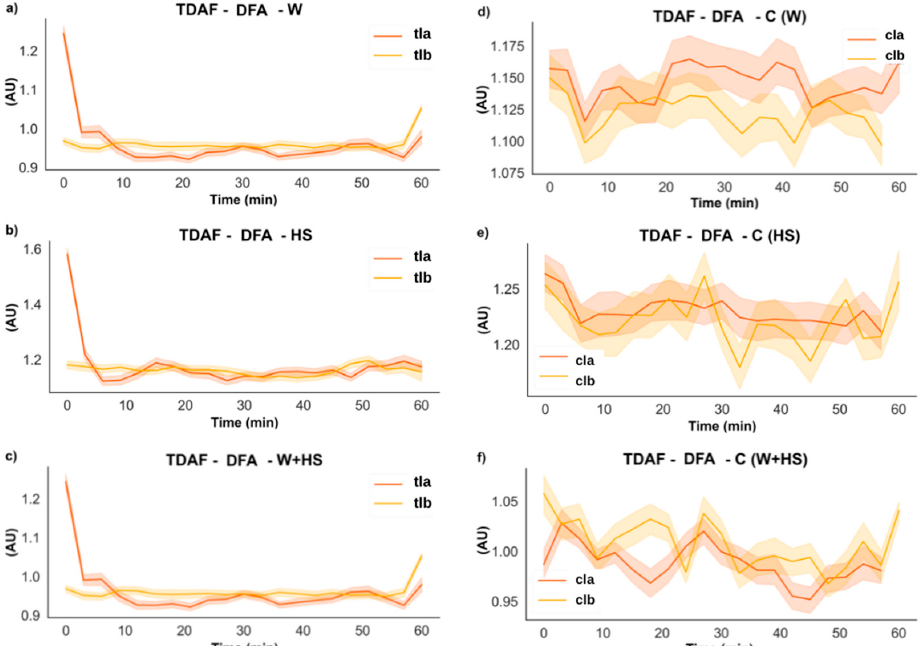
Figure 5. TDAF plots for DFA analysis. Results for ( a ) the local wound (W), ( b ) heat shock (HS), and ( c ) wound + heat shock (W+HS). Results of the control plants for ( d – f ) wound C (W), heat shock C (HS), and wound + heat shock C (W+HS), respectively. tlb: treated local before stimulus; tla: treated local after stimulus; clb: control local before stimulus; cla: control local after stimulus. AU: arbitrary unit.